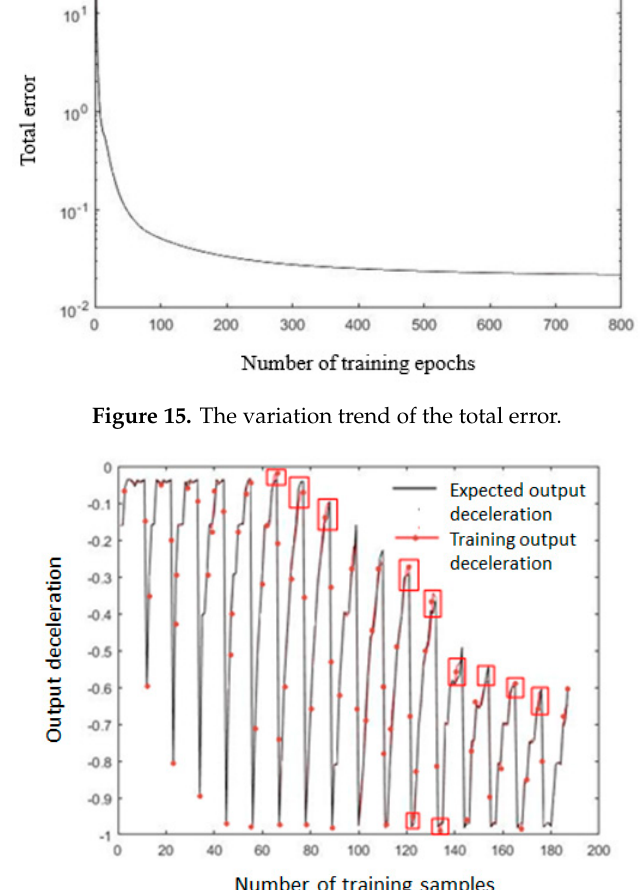
Figure 16. The comparison of expected and training deceleration values.